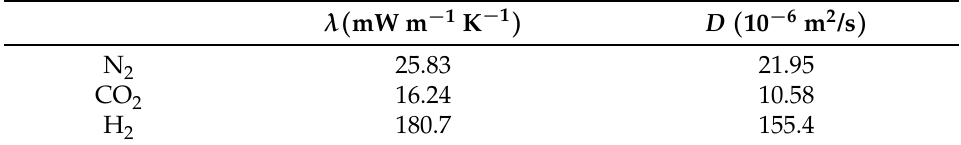
Table 3. Overview of the thermal conductivity and thermal diffusivity for CO 2 , H 2 , and N 2 at